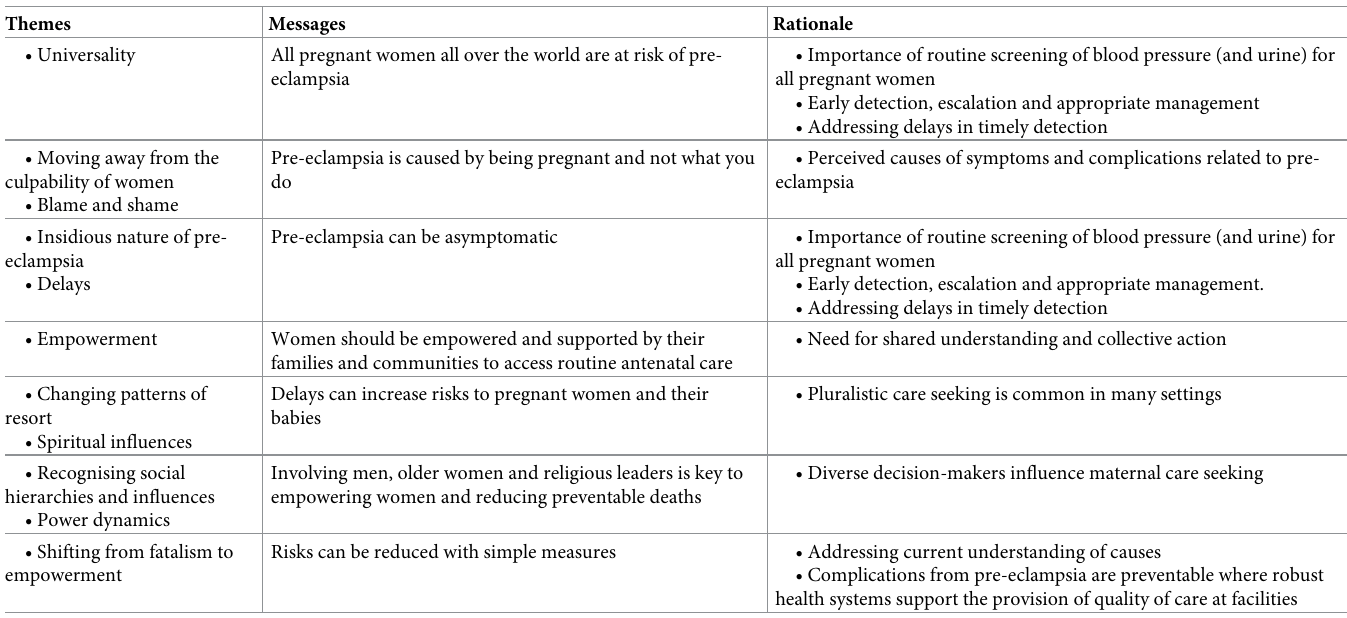
Table 2. Consensus key messages.